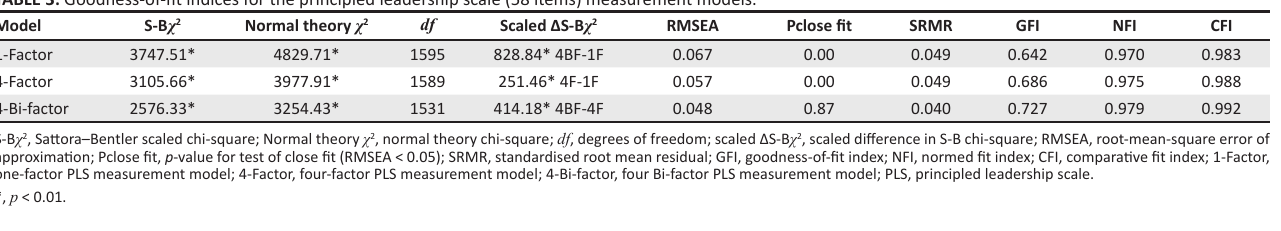
TABLE 4: Completely standardised LAMBDA-X factor loadings of the bi-factor measurement model. Item